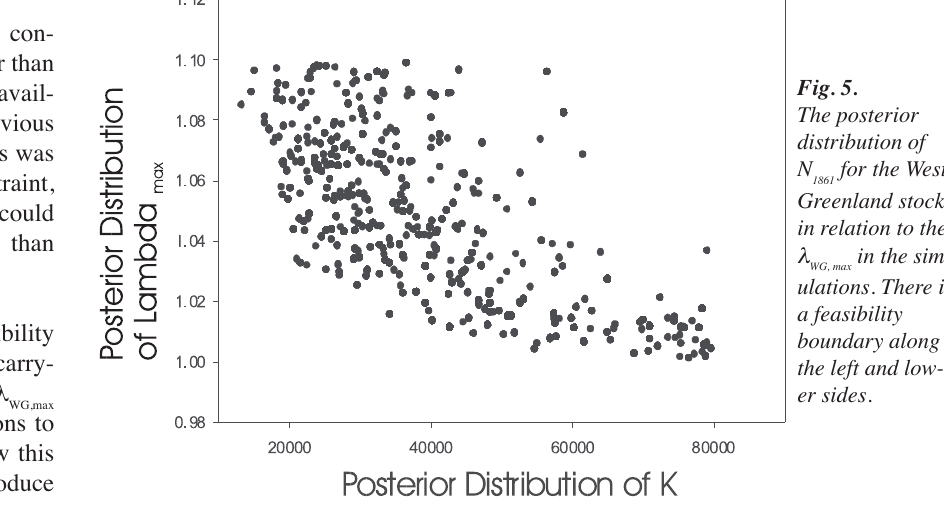
The posterior distribution of N for the West 1861 Greenland stocks in relation to the λ in the sim- WG, max ulations. There is a feasibility boundary